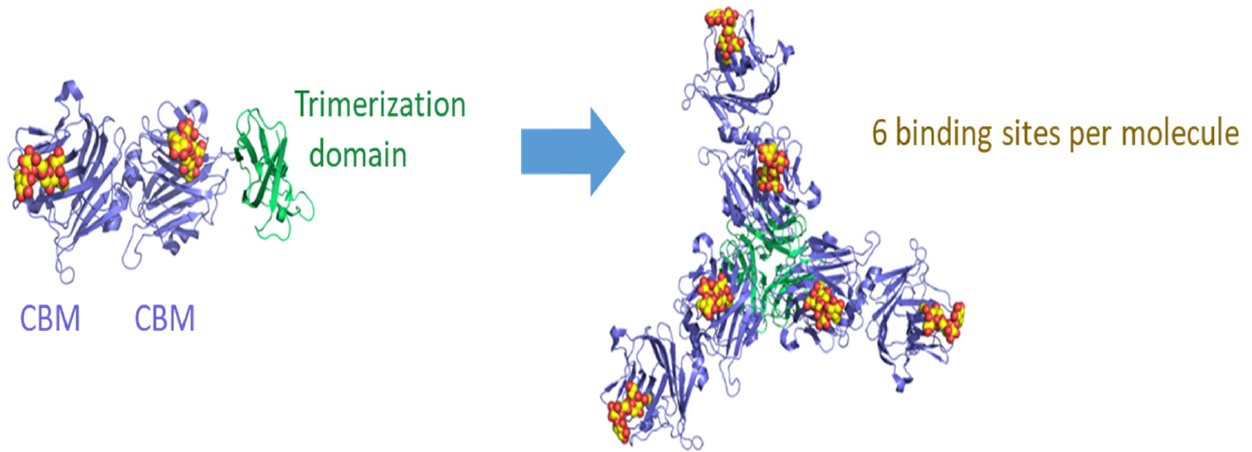
Figure 1. Schematic diagram of CBM domain arrangement and trimerisation in the Neumifil com- pound. Bound 2,3 sialyllactose molecules (shown as spheres) indicate the ligand-binding sites. The image was produced with PyMOL Molecular Graphics System (Version 2.0., Schrödinger, LLC). PDB accession codes: 4c1w and 2w38.